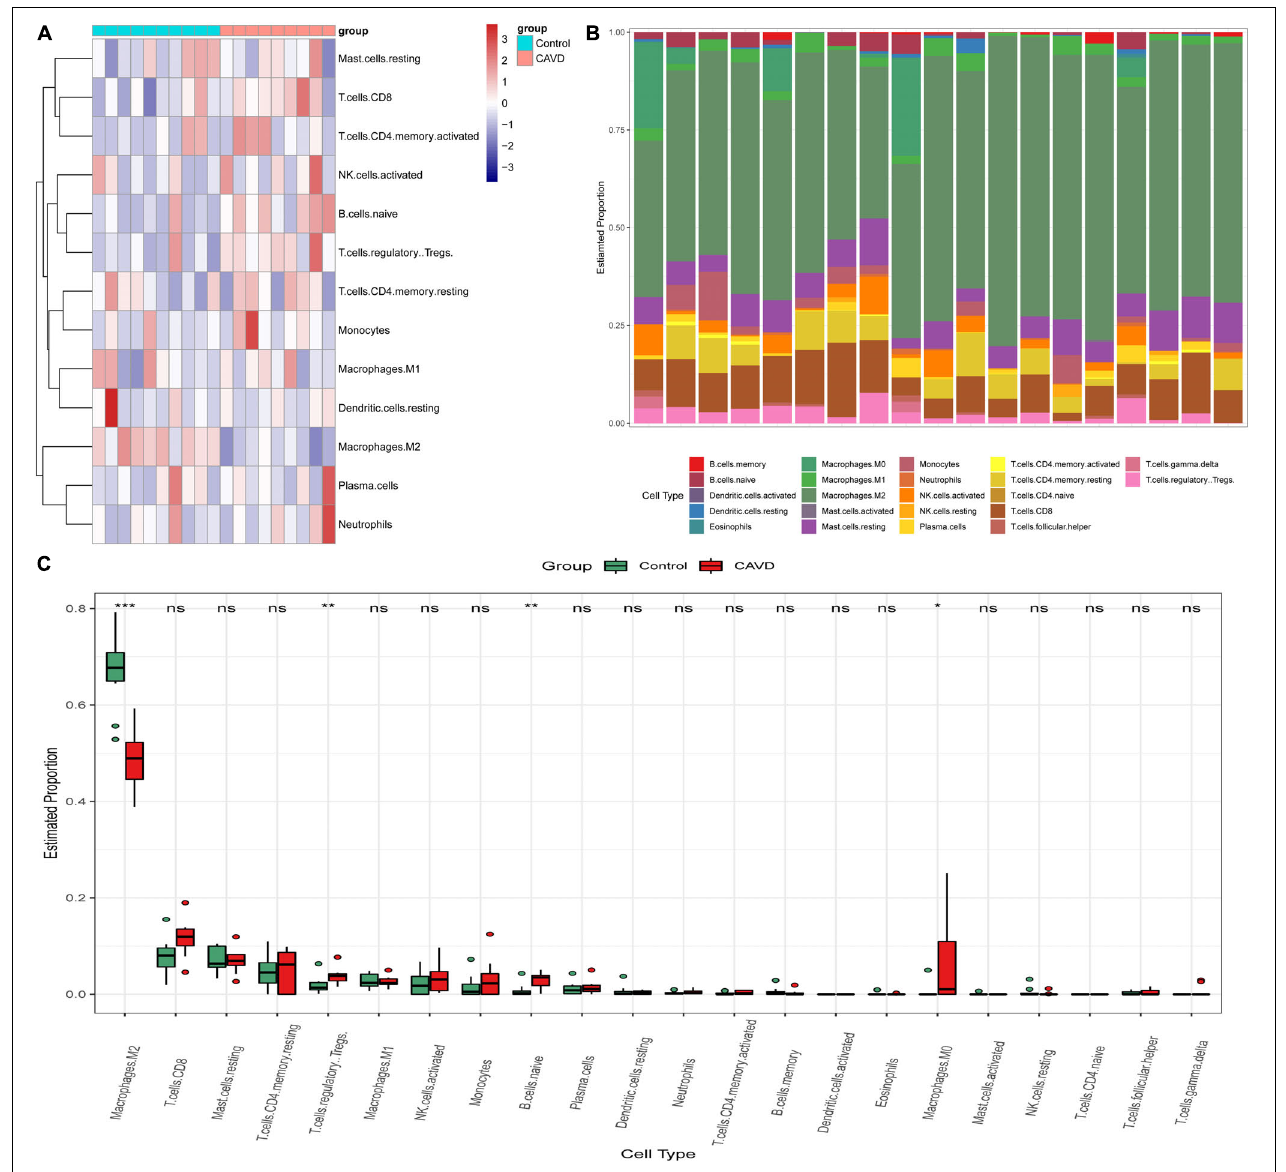
FIGURE 9 | Immune infiltration analysis in GSE55492 by CIBERSORT. (A) Heatmap of various immune cells in each sample. (B) The bar plot of various immune cell distributions in each sample. (C) Differences in immune infiltration between calcified aortic valve samples and normal samples by the Wilcox test. Red represents calcified aortic valve samples, and green represents normal samples. The x -axis shows the different types of immune cells, and the y -axis shows the proportion of immune cells. * P < 0.05; ** P < 0.01; *** P <